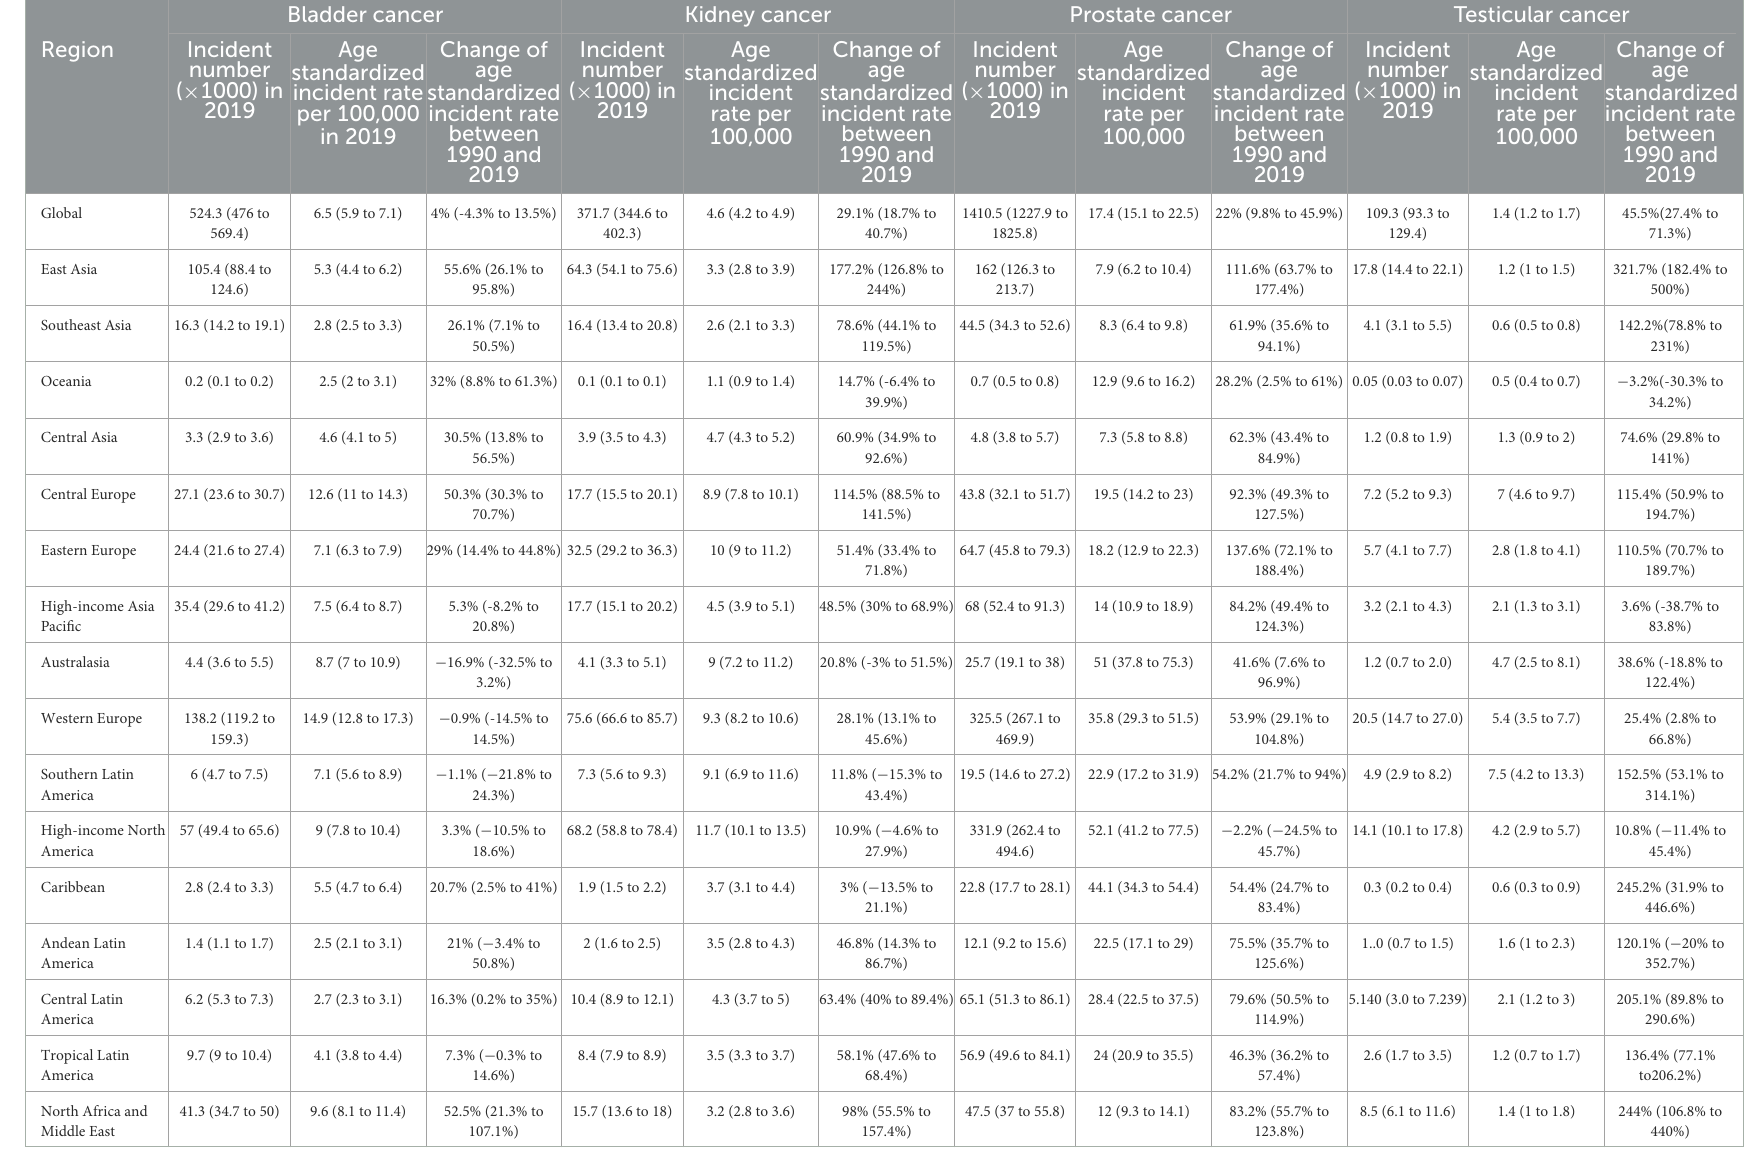
TABLE 1 Incident number, age standardized incident rate in 2019 and the percentage change of incident rate for bladder, kidney, prostate and testicular cancer between 1990 and